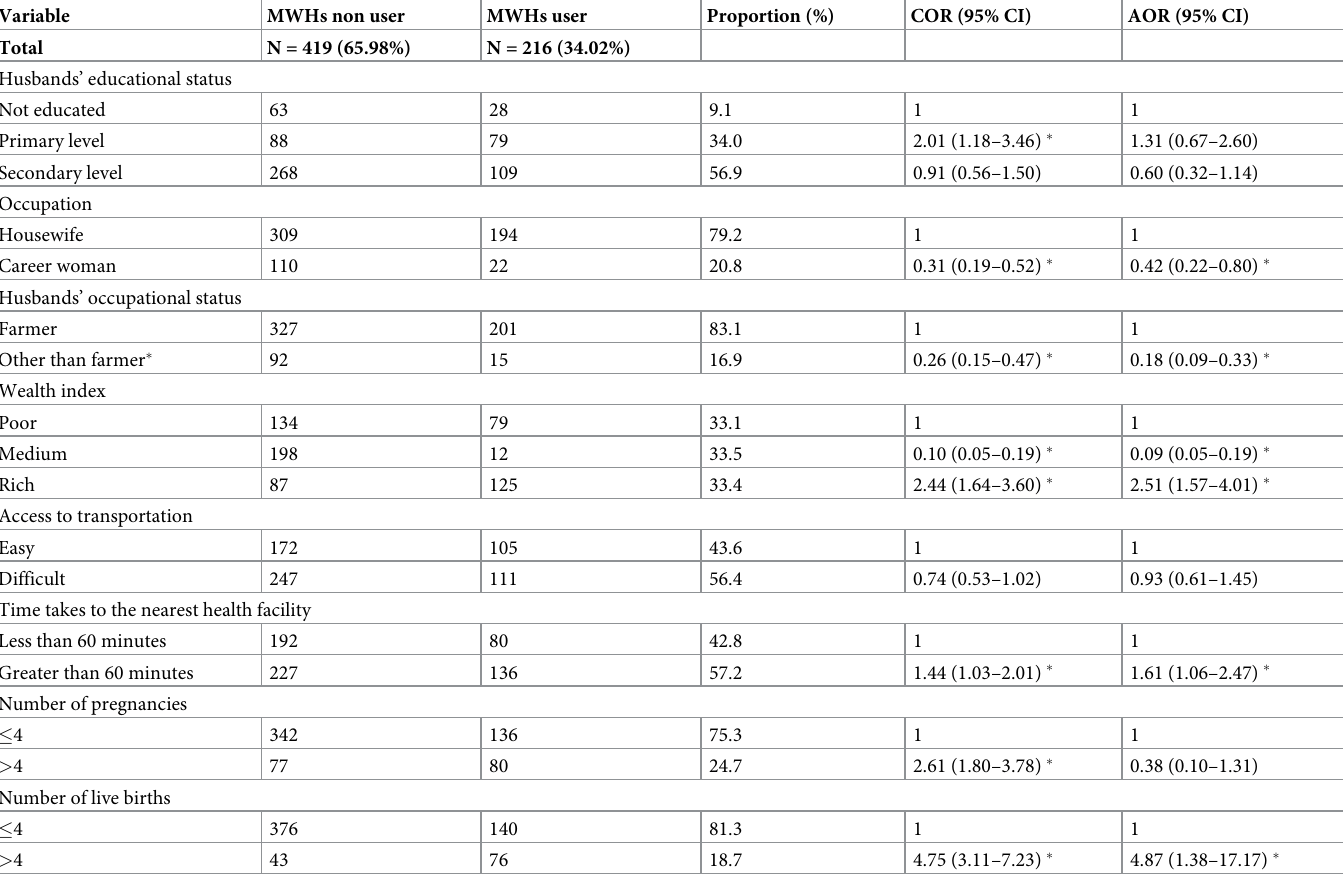
Table 3. Factors associated with MWHs utilization among childbearing women at Finfinnee special zone of central Ethiopia (N =